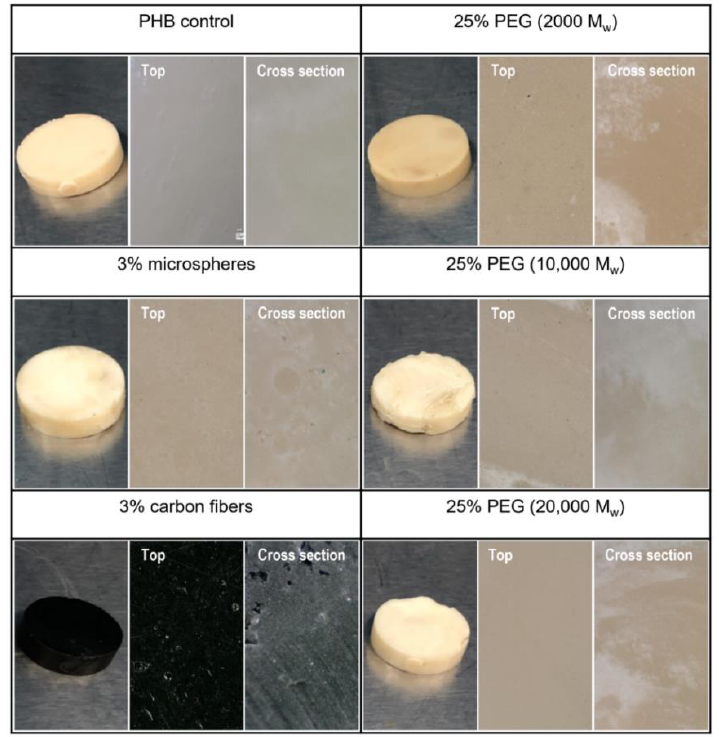
Figure 5. PHB composite sample surfaces photographed at 1 × , 20 × , and 100 × for the analysis of surface changes. The 20 × and 100 × photographs were taken under full ring lighting conditions.